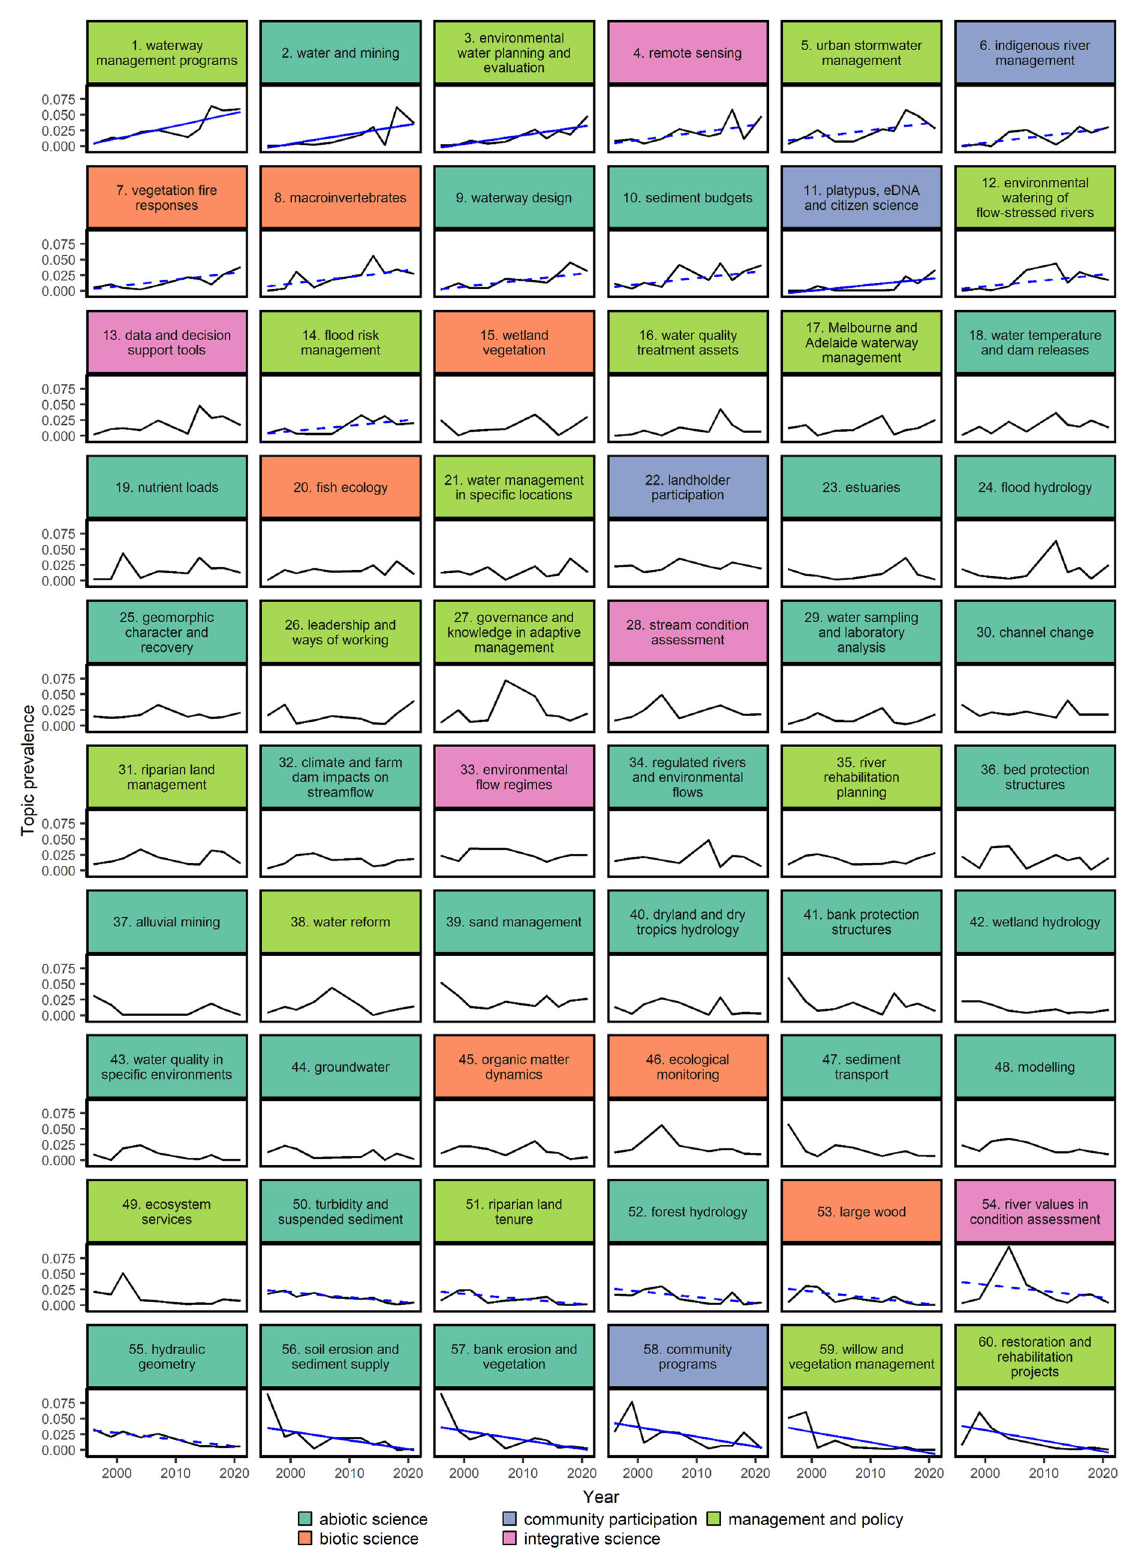
Fig. 4 Topic prevalence over time. Black lines show topic prevalence, solid blue lines indicate trends with p < 0.01 (considered here to be signi fi cant trends), dashed blue lines indicate trends with 0.01 < p < 0.05 (considered here to be trends supported by weak evidence). Topics are ordered by the strength of the trend, from highest positive at the top to highest negative at the bottom. Topic labels are coloured by discipline (abiotic science in dark green, biotic science in orange, community participation in purple, integrative science in pink, management and policy in light green). For details of topics, see Supplementary Table